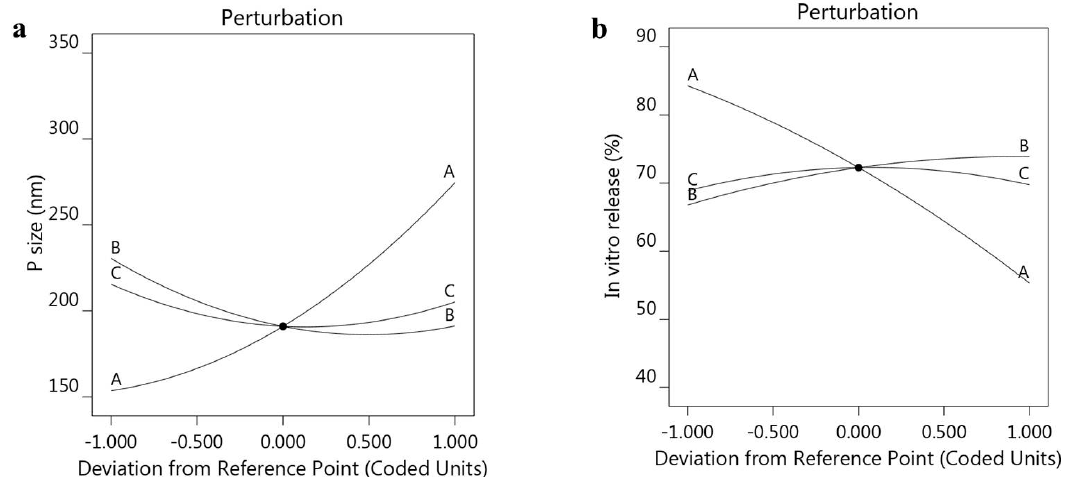
Figure 3. Perturbation plots displaying the influence of each independent variable alone on ( a ) particle size R 1 , and ( b ) in vitro release R 2 . ( a ) particle size R 1 , and ( b ) in vitro release R 2